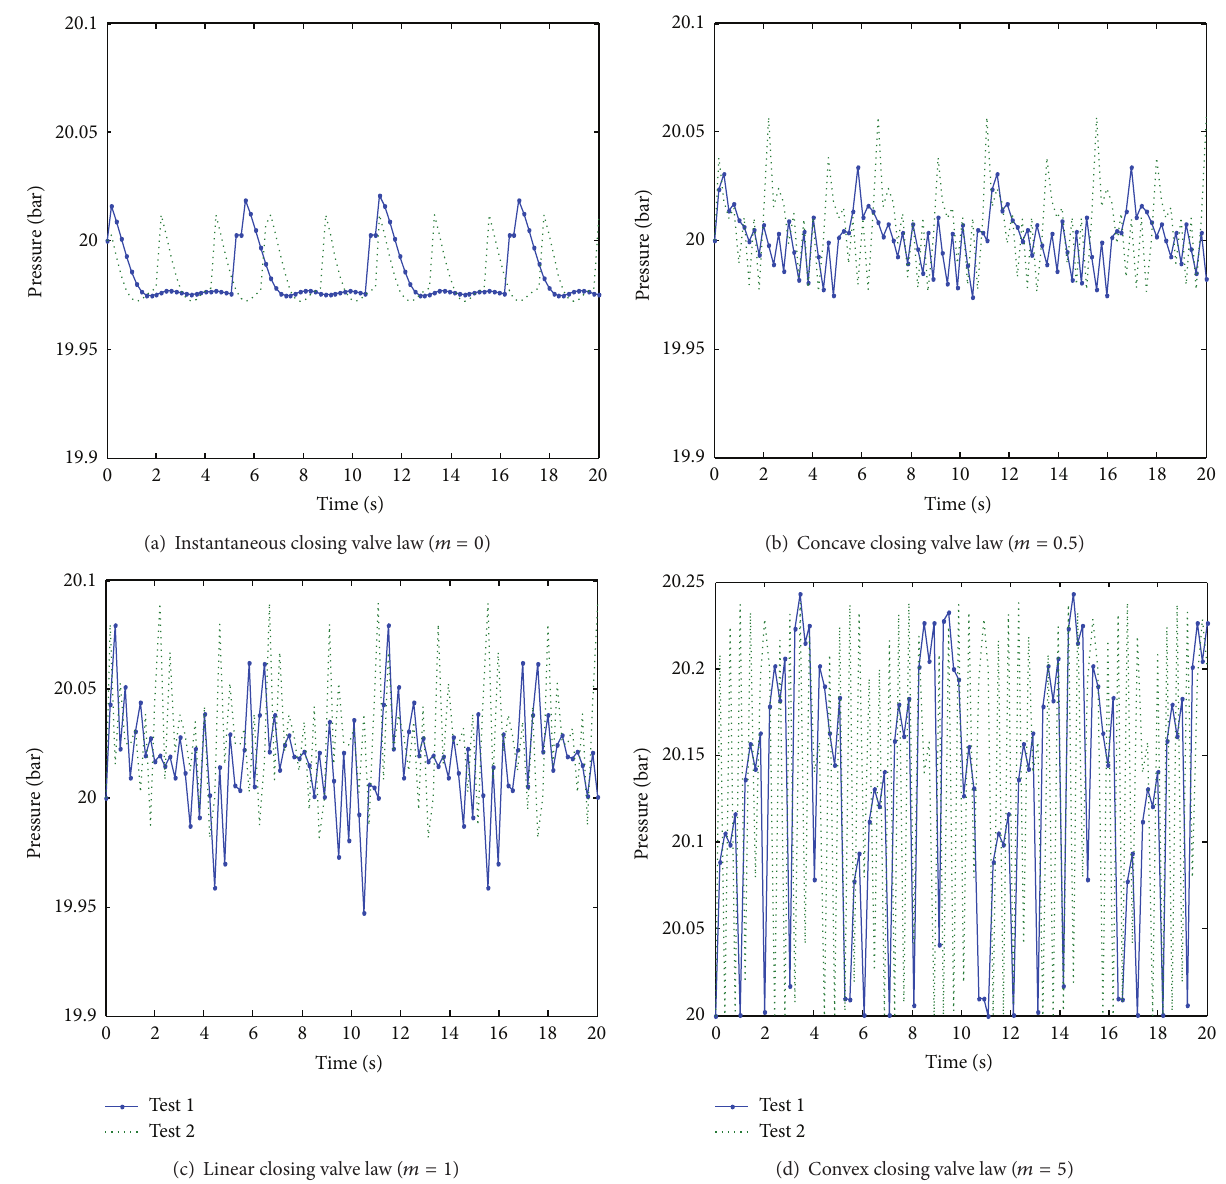
Figure 5: Transient pressure waves as function of time, 33% mass ratio of hydrogen-natural gas